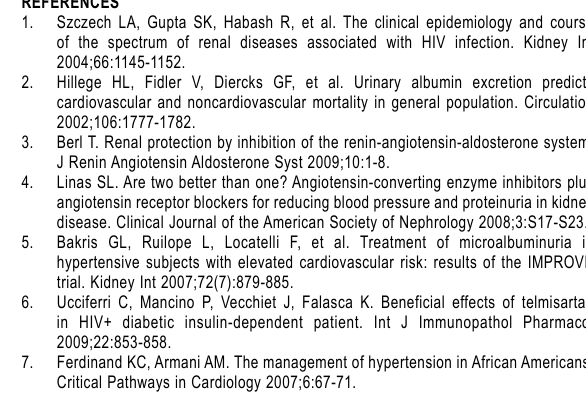
was given for the